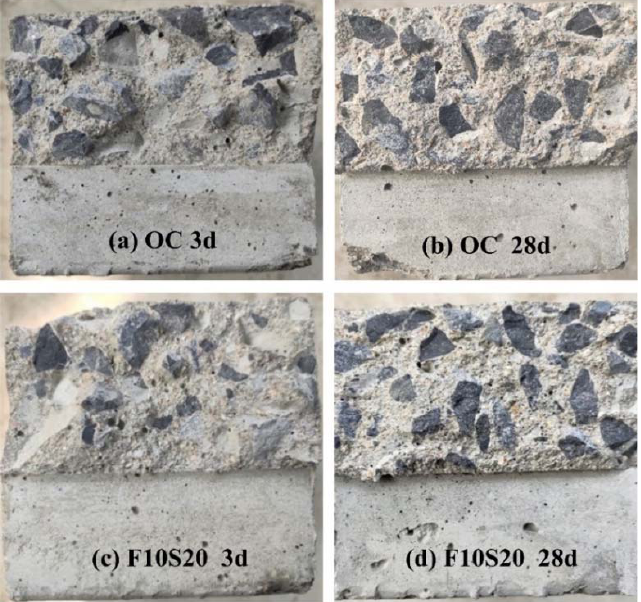
Figure 8. Fracture surfaces of OC and F10S20 concrete specimens: ( a ) OC concrete at 3 d; ( b ) OC concrete at 28 d; ( c ) F10S20 concrete at 3 d; ( d ) F10S20 concrete at 28 d.